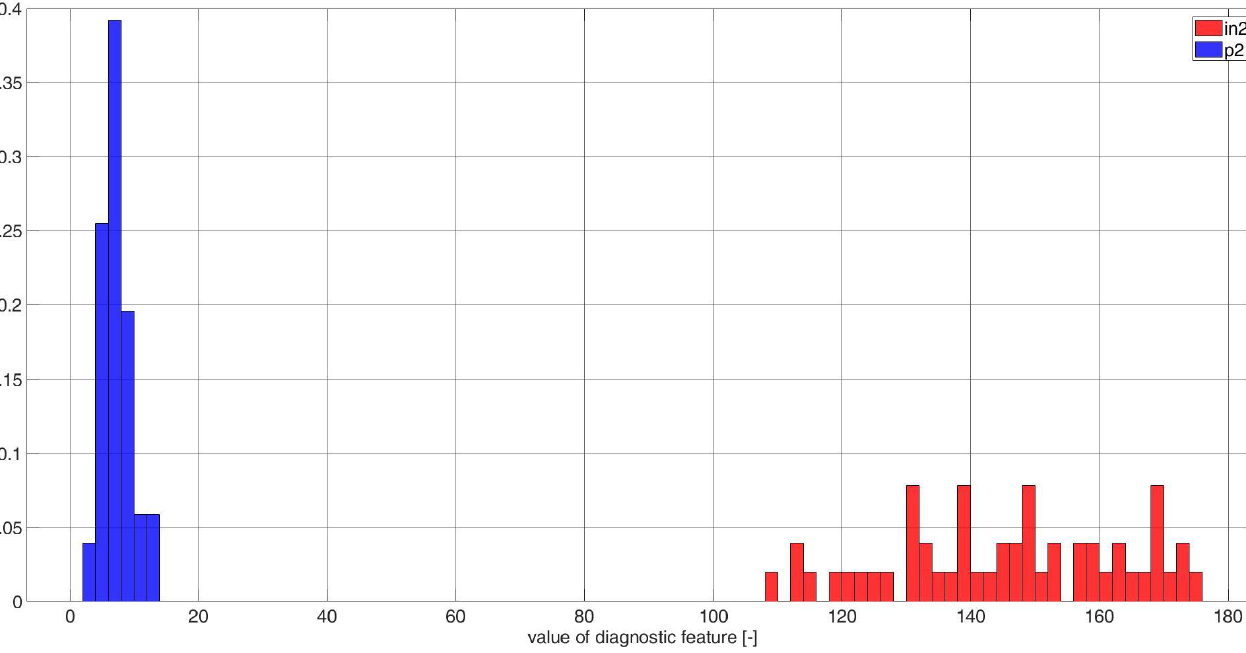
Figure A22. Histograms of diagnostic features based on the CCSM3 (correlation number is 22— Table A1) bearings in2 and p2.